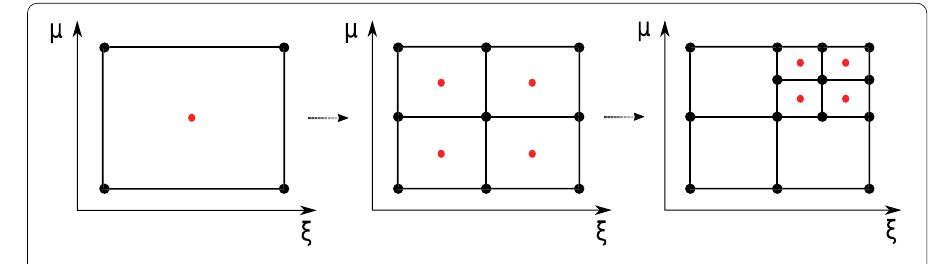
Fig. 10 Successive localized refinements for a 2D parameter space